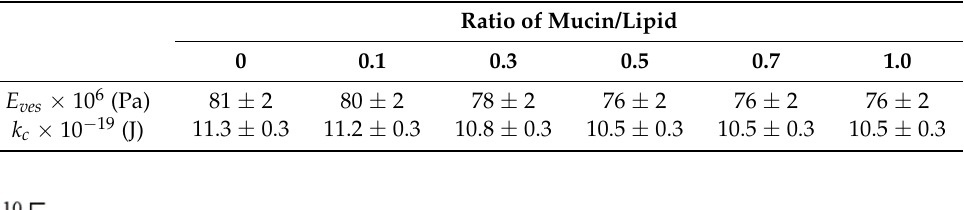
Table 2. Change in Young’s modulus ( E ves ) and bending modulus ( k c ) of the dipalmitoylphosphatidyl- choline vesicles, with respect to the ratio of mucin/lipid.